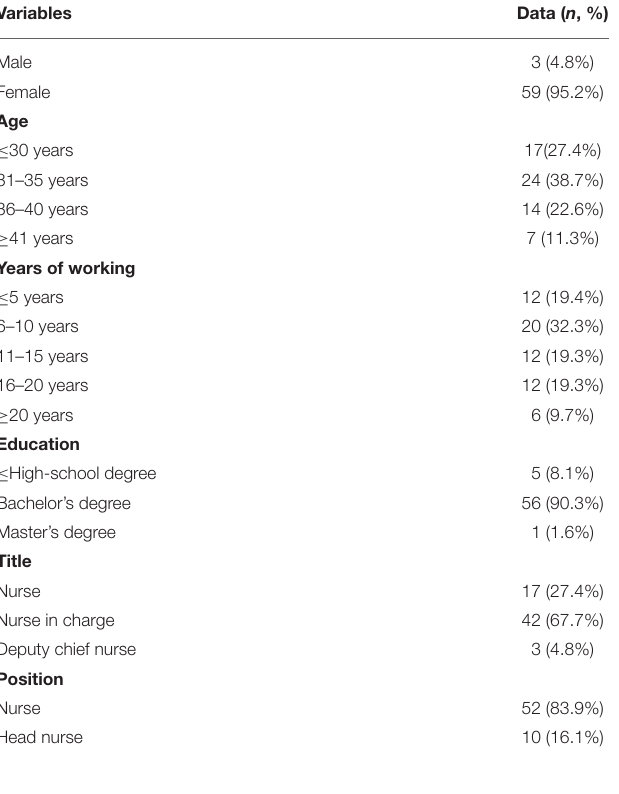
TABLE 1 | Basic data of study subjects ( n = 62).